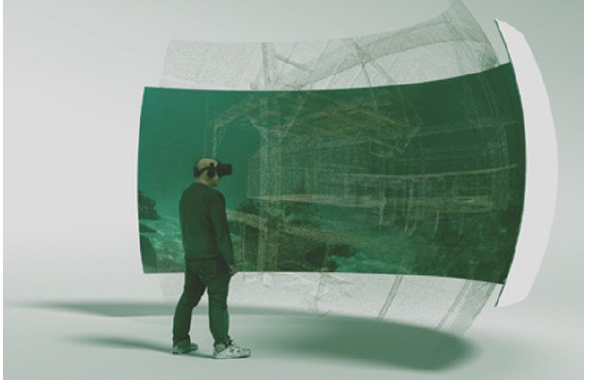
Figure 3. Panoramic Speculative Reconstruction of Lot